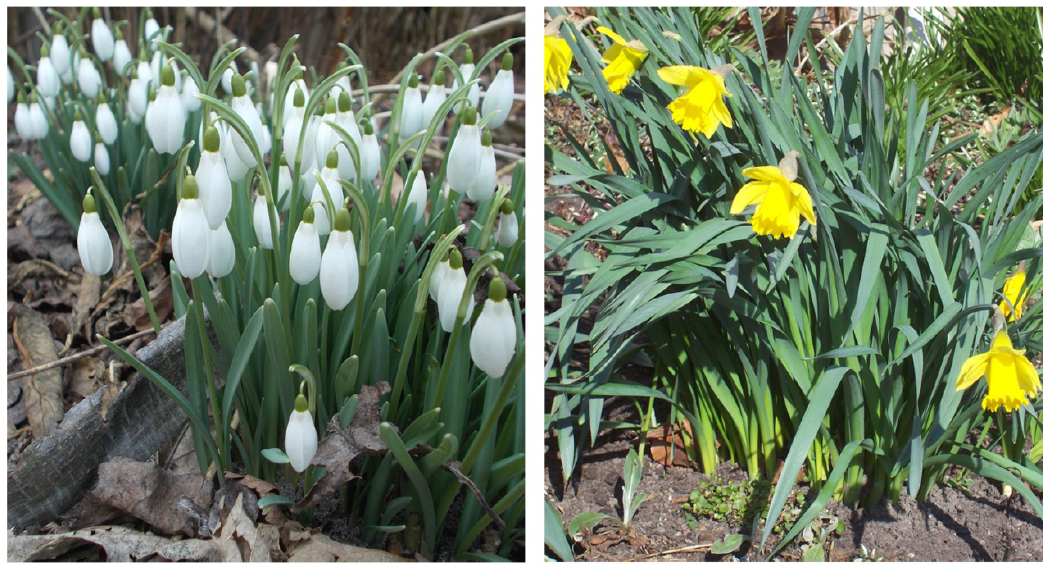
Figure 1. Amaryllidaceae species from genera such as Galanthus (snowdrops, left ) and Narcissus (daffodils, right ) are popular as ornamental plants in